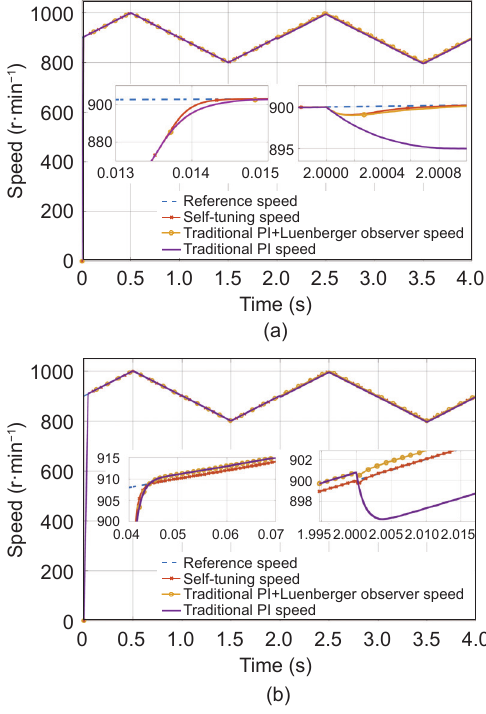
Fig. 17 Adaptive control effects of the combination of traditional PI and Luenberger observer. (a) B